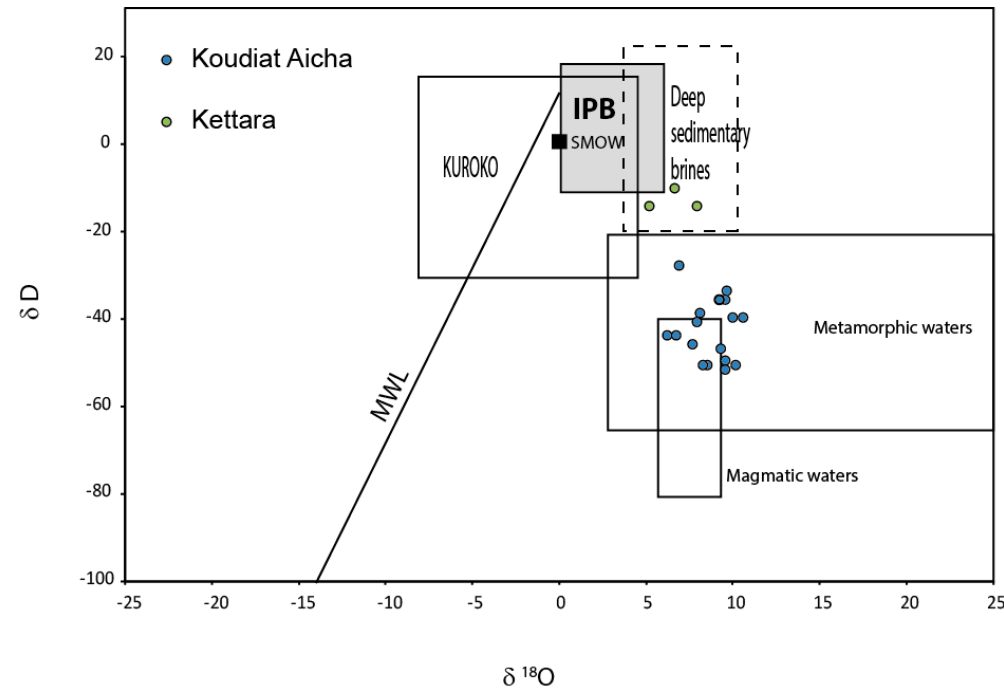
Figure 8. δ D and δ 18 O values of ore forming fluids in Koudiat Aicha and Kettara deposits as compared to those of the Iberian Pyrite Belt (IPB) (grey box) and fluids from other reservoirs. Data from [115–117].